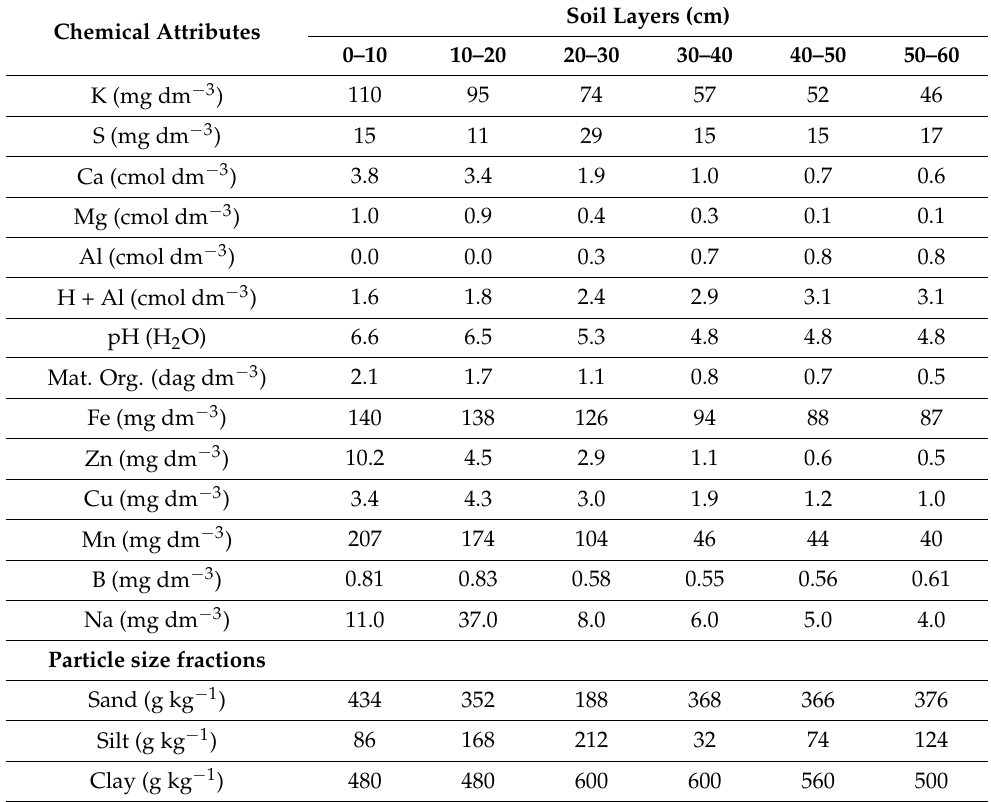
Table 1. Chemical and granulometric characteristics in six soil depths (Yellow Latosol) in an